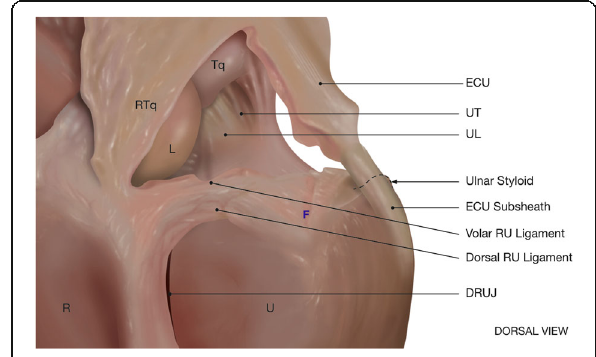
Fig. 1 TFCC anatomy. Palmar and dorsal radio-ulnar (RU) ligaments, ulnocarpal ligaments (UL, UT) are displayed. (ECU = extensor carpi ulnaris, DRUJ = distal radio-ulnar joint, R = radius, U = ulna, L = lunate, Tq = triquetrum, RTq = radiotriquetral ligament, F = ulnar fovea)